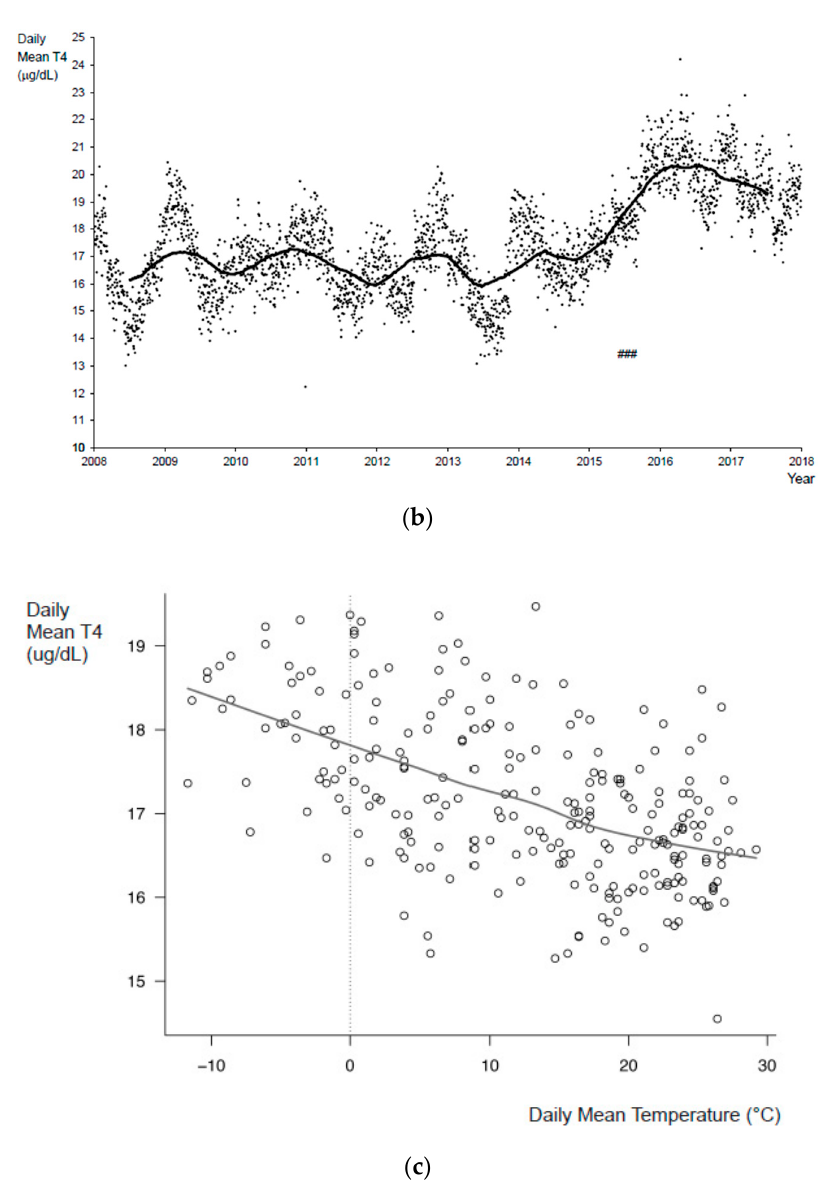
Figure 2. ( a ) Daily mean TSH values for all specimens from 2008 to 2017. The black dots represent daily mean TSH values. The black line represents the long-term trend of daily TSH values. ( b ) Daily mean T4 values for all specimens from 2008 to 2017. The black dots represent daily mean T4 values. The black line represents the long-term trend of daily T4 values. Hashtags represent the kit lot change from 27 April to 9 September, 2015. ( c ) Daily mean T4 values and daily mean temperature for 2014. The open circles indicate the daily mean values, and the solid line is the LOESS trend. Note that the T4 levels are higher when the ambient temperature is low, and with increasing temperature, the daily mean T4 levels decrease.